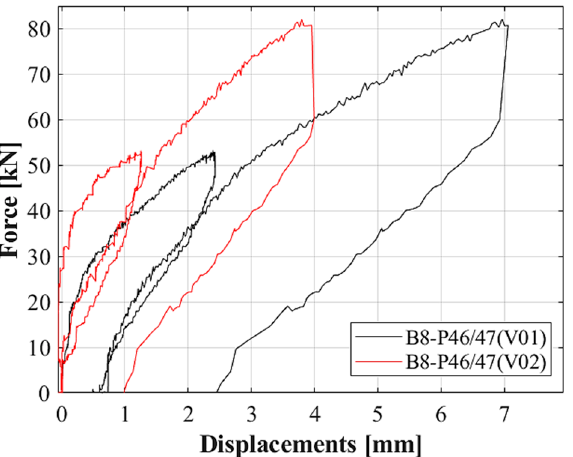
Figure 13. Vertical displacements of the support for the B8-P47/46 beam.